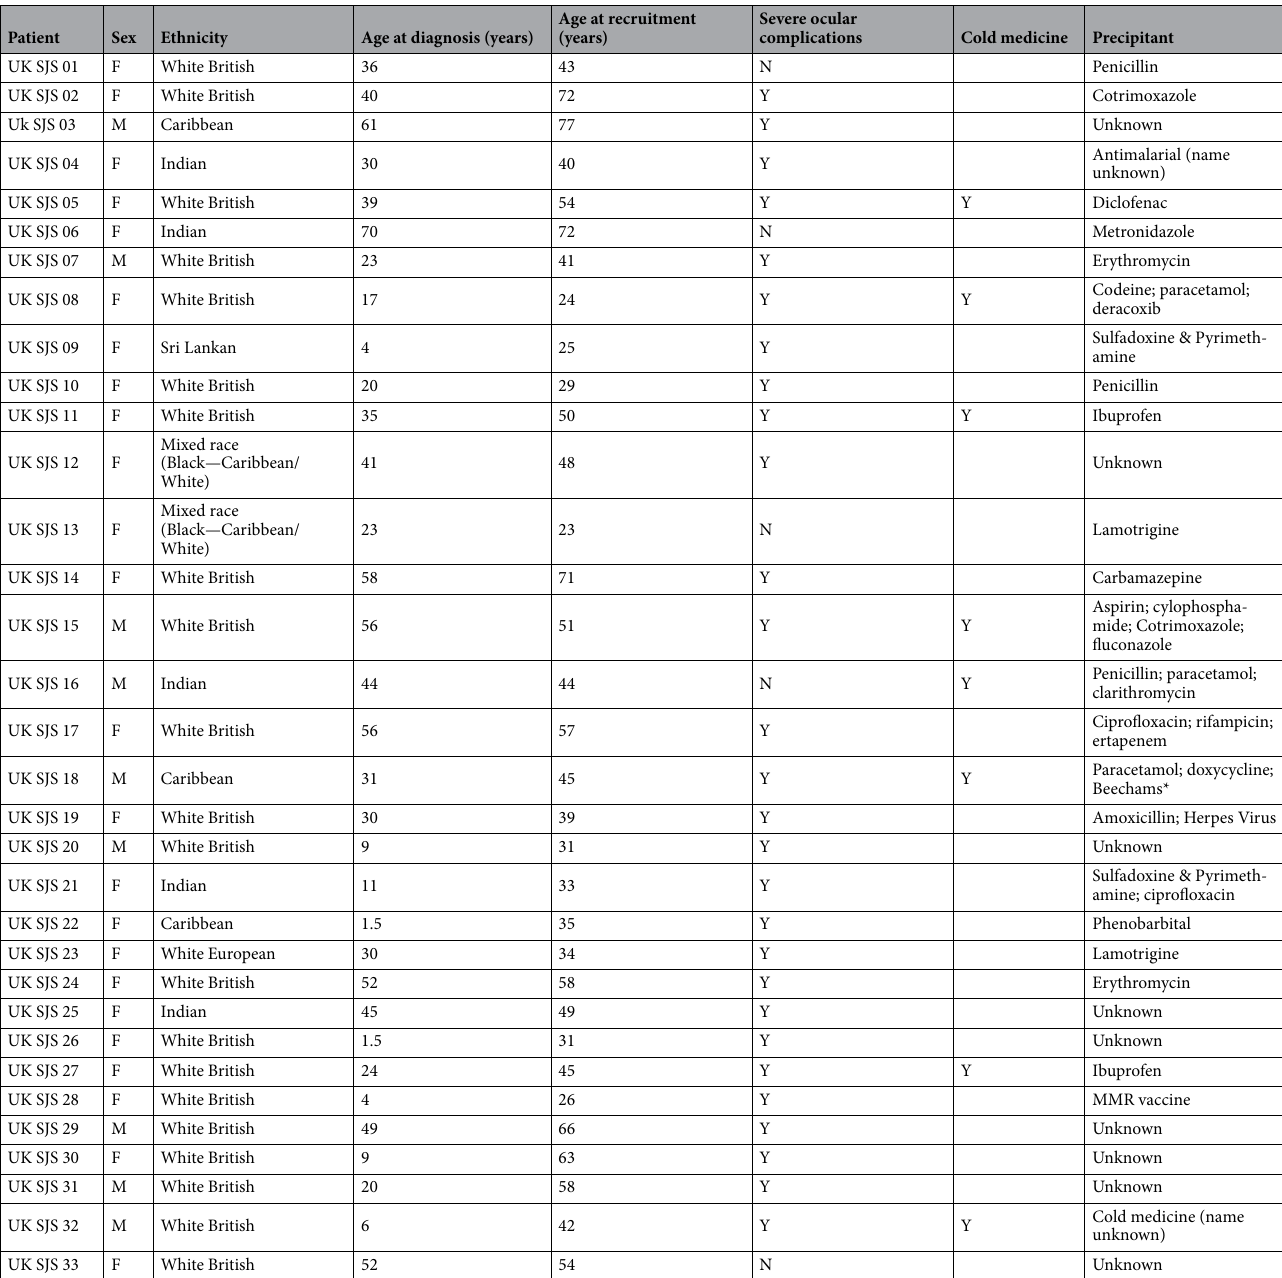
Table 2. SJS/TEN clinical characteristics. *Beechams is a part of the Glaxo Smith Klein companies. They produce a number cold & flu formulations which contain a range of ingredients including acetaminophen, non-steroidal anti-inflammatories, caffeine, and phenylephrine. No further precipitant specificity was